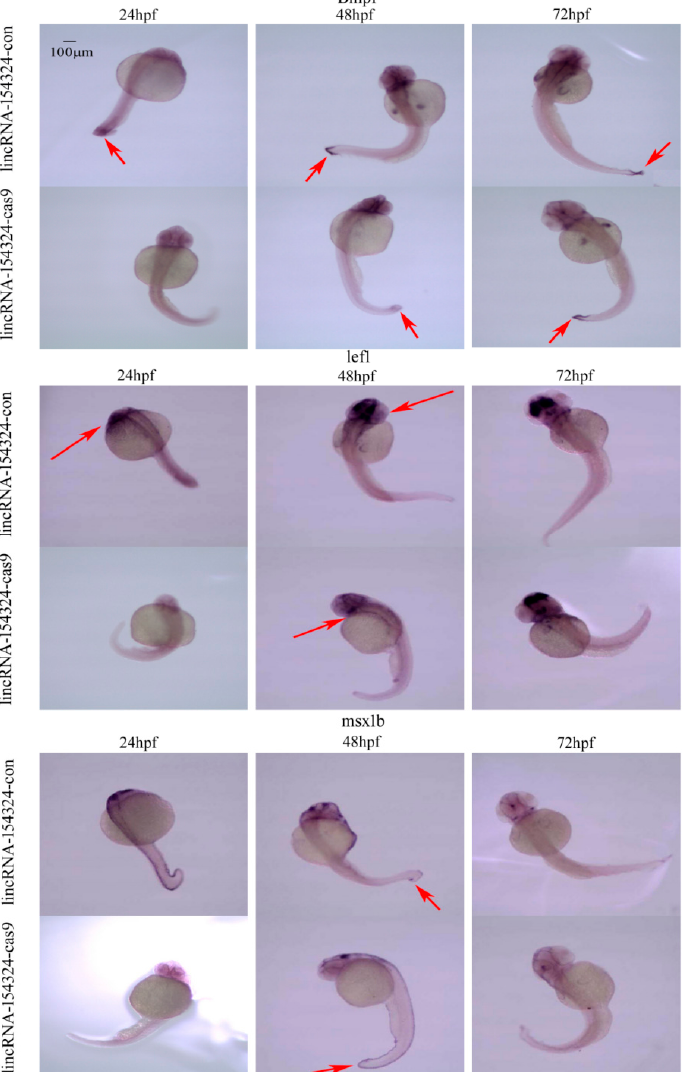
Figure 14. The temporal and spatial expression of marker genes related to caudal fin regeneration in 24–72 hpf embryos after lincRNA-154324 gene knockout. Bmp1a , lef1 , and msx1b spatial expres- sion in the lincRNA-154324-con and lincRNA-154324-cas9 groups at different stages of zebrafish embryogenesis. Red arrows: pointing to the site of gene expression. Scale bars: 100 µ